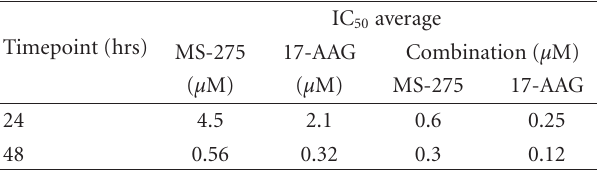
Table 1: Comparison of IC 50 values at 24- and 48 hour Timepoints for MS-275 and 17-AAG as single agents and in combination using MTT